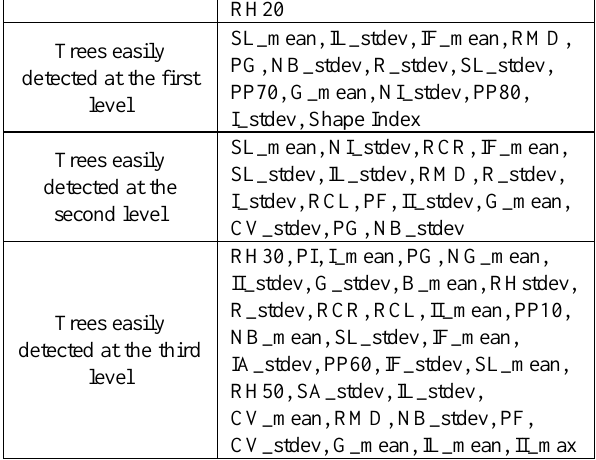
Table 3. Results of feature